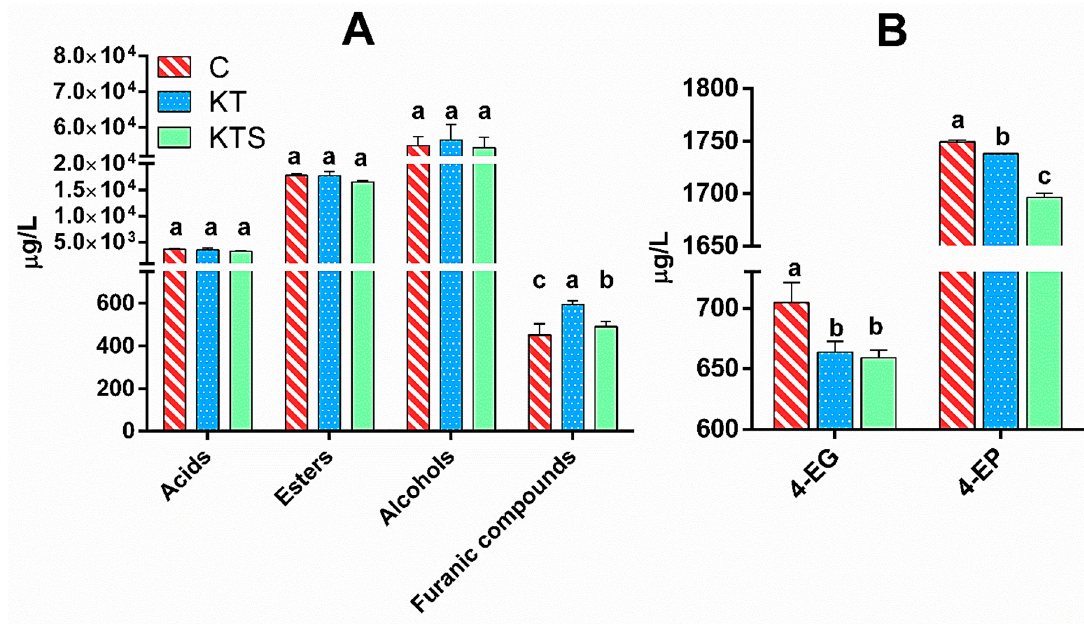
Figure 2. ( A ) Quantification of volatile compounds grouped by chemical families and ( B ) quantification of 4 ‐ ethyl phenol (4 ‐ EP) and 4 ‐ ethyl guaiacol (4 ‐ EG) in wines after 7 days of treatment. In the same row, different letters indicate significant differences according to Tukey’s test ( p < 0.05). n = 3. C: no addition; KT: 0.5 g/L of solid chitosan; KTS: 0.5 g/L of chitosan in solution.